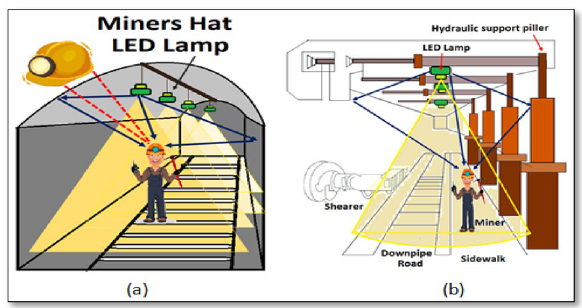
Table 7 Specifications for simulation Width of the room 10 m Length of the room 5 m Height between transmitter (LED) and receiver (PD) 10 m Responsivity of PD 0.55 A/W Transmitter FOV 70 deg Receiver FOV 90